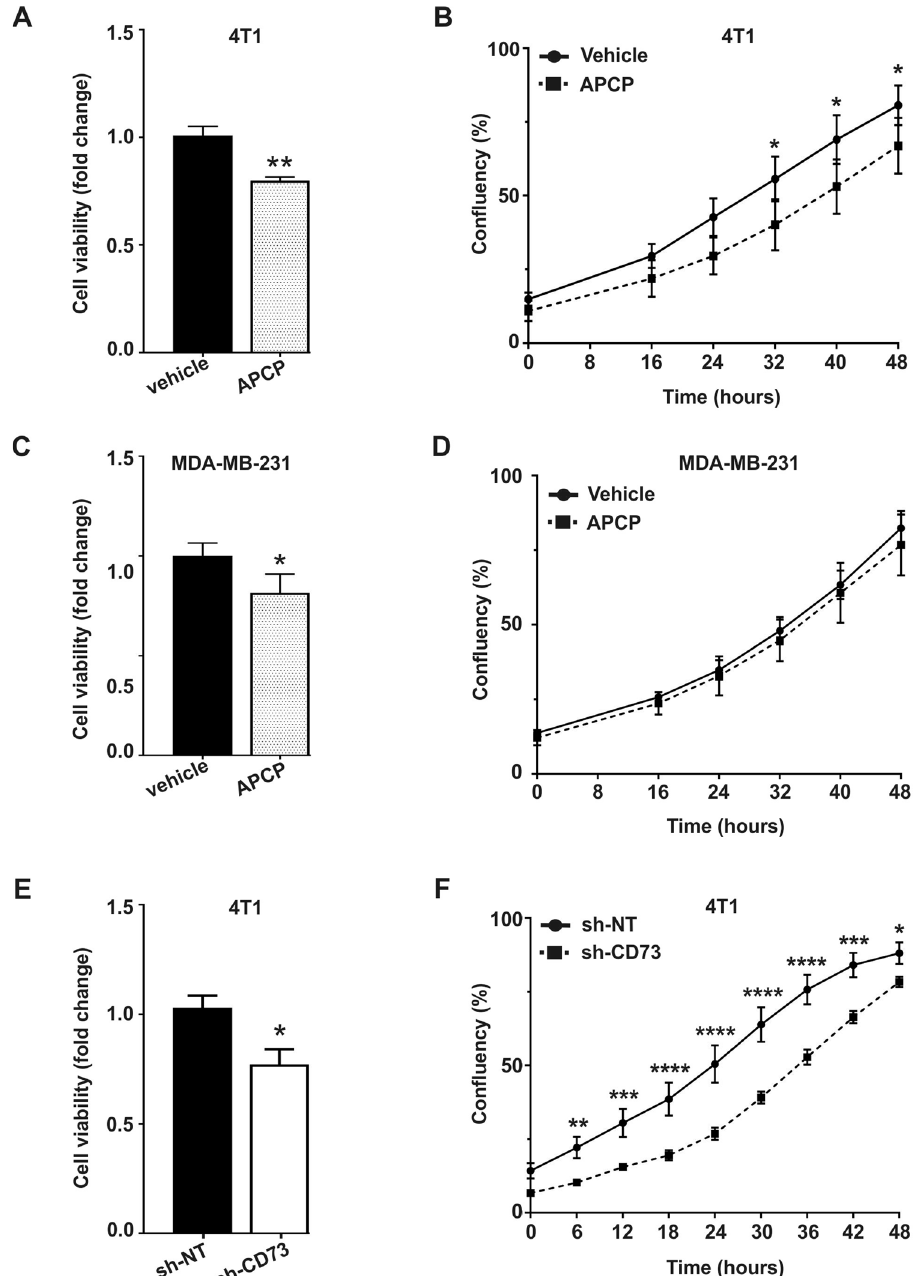
Figure 1. CD73 suppression inhibits cell viability and proliferation in normoxia. Cell viability was measured by WST-8 assay. Cell proliferation was assessed with confluence analysis. Viability ( A ) and proliferation ( B ) of APCP-treated 4T1 cells in normoxia. Viability ( C ) and proliferation ( D ) of APCP-treated MDA-MB-231 cells in normoxia. Viability ( E ) and proliferation ( F ) of sh-NT (control) and sh-CD73 4T1 cells in normoxia. The bars represent fold-change in viability vehicle-treatment ( A , C ), or vs. sh-NT cells ( E ). Cell proliferation rates are expressed as percentages of confluency ( B , D , F ). The cell confluency was analyzed using IncuCyte 2018B software (Essen Bioscience). The results are expressed as mean ± SD, n = 3. *P < 0.05, **P < 0.01 and ***P < 0.001 are considered to be statistically significant compared to representative control cells, by two-tailed Student’s